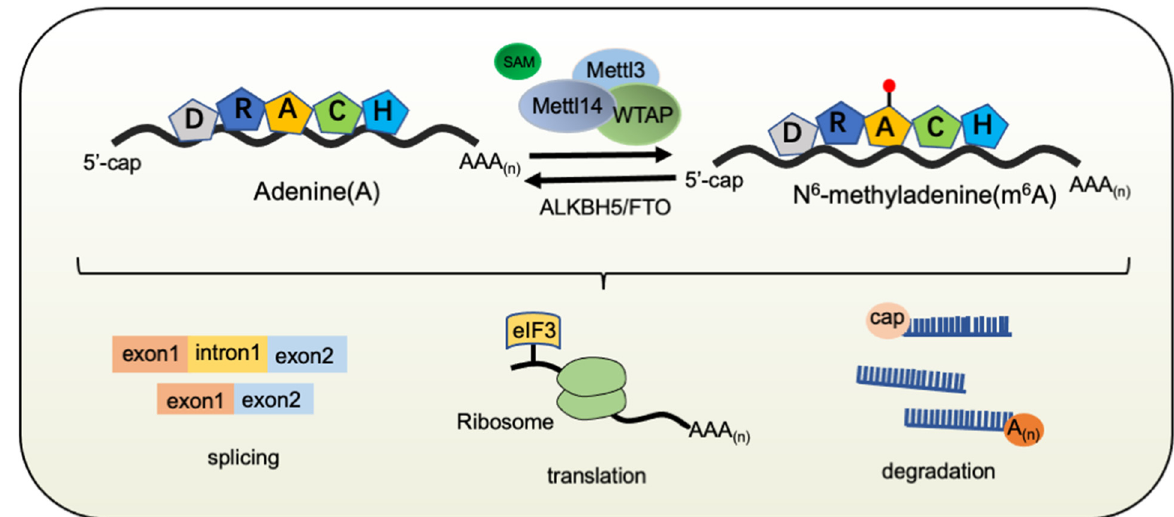
Figure 1. Schematic illustration of m 6 A modification. m 6 A methylation is catalyzed by the methyltransferase complex containing Mettl3, Mettl14, and an adaptor protein, such as WTAP. Fto and Alkbh5 can function as demethylases, and Yth family proteins can recognize m 6 A sites. m 6 A modification in mammals is presented on the consensus sequence DRACH (D = A/G/U, R = A/G, H = A/C/U). Reversible m 6 A modification plays important roles in regulating RNA metabolism, including RNA splicing, nuclear export, translation, and degradation in the specific context. Mettl3, methyltransferase-like 3; Mettl14, methyltransferase-like 14; WTAP, Wilms tumor 1-associating protein; Fto, fat mass and obesity-associated protein; ALKBH5, AlkB homolog 5.